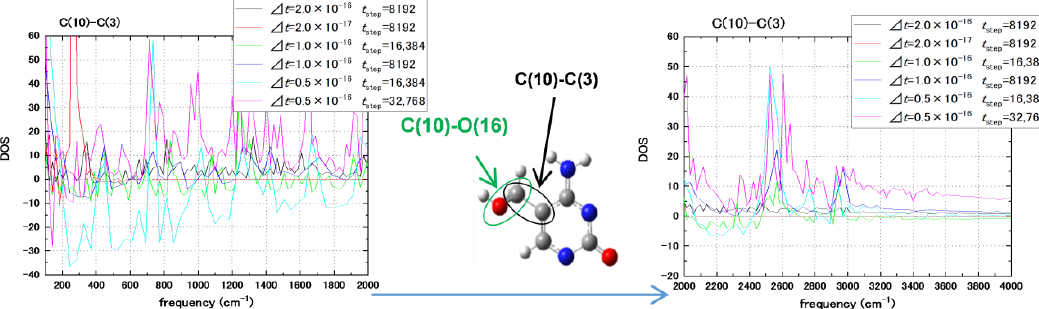
Figure 4. The spectra of a single bond marked as C(10)-C(3) in internal atom numbering of the hydroxymethylcytosine (HMC) nucleotide. The C(10) atom belongs to the hydroxymethyl group and exhibits high frequencies of the C-H bond. The spectra are collected outside of graphene pore interaction (v z = 0) at a different propagation time step (2.0 ÷ 0.5 × 10 − 16 s) and total simulation time (in step number) in two frequency domains: 0–2000 cm − 1 at the left and 2000–4000cm − 1 at the right. The base part of the HMC nucleotide with the marked bond adjacent to H-X (C, O) is shown in the center.